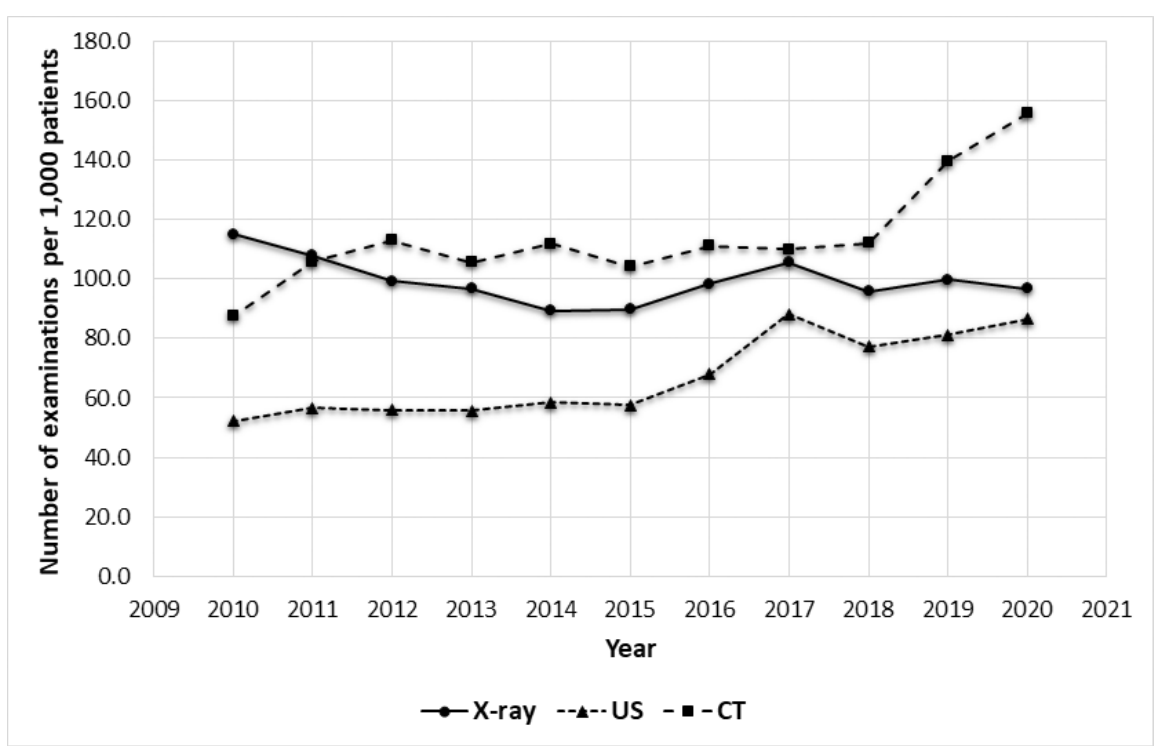
Figure 1. Annual changes in the number of CT, US, and X-ray examinations. Table 2. The number of chest CT examinations per 1000 patients performed in 2019 and during the COVID-19 pandemic in 2020. The years are presented in descending order.